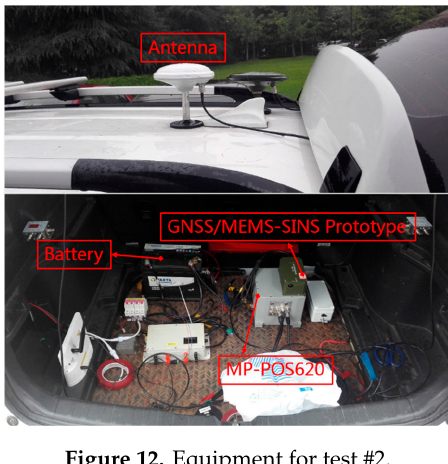
Figure 11. Trajectory and four typical GNSS challenging environments of test #2.